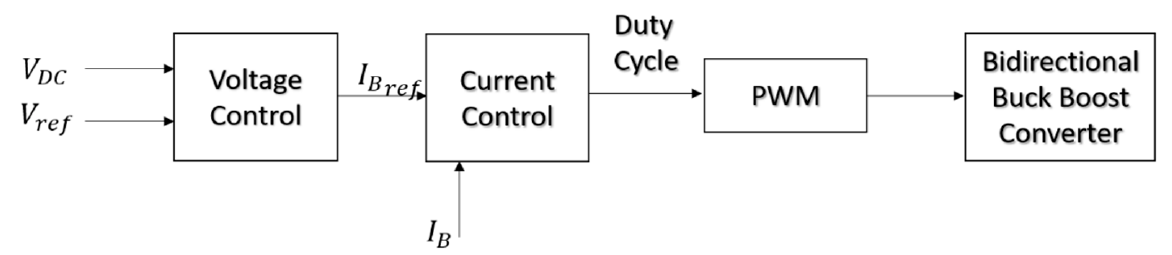
Figure 6. Battery local control.